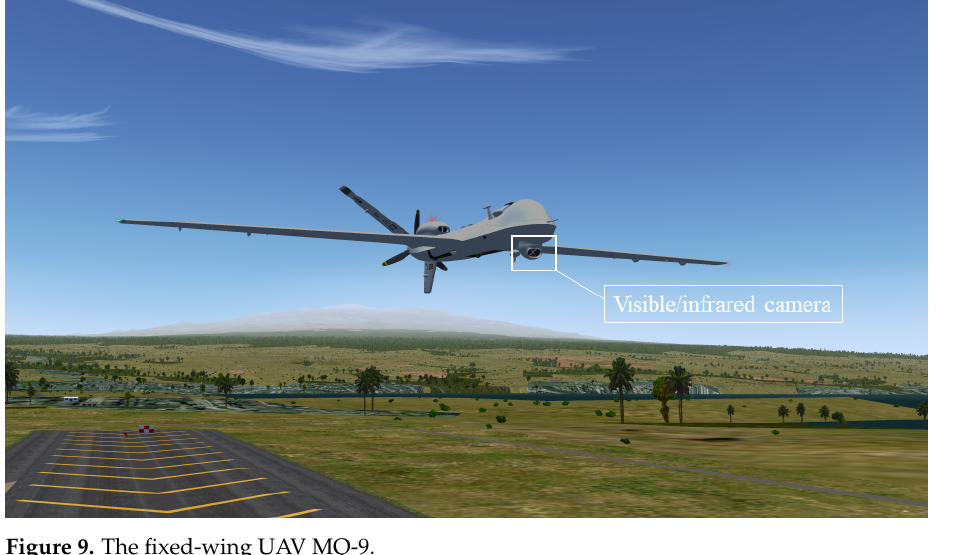
Figure 9. The fixed-wing UAV MQ-9. Table 1. The MQ-9 properties.